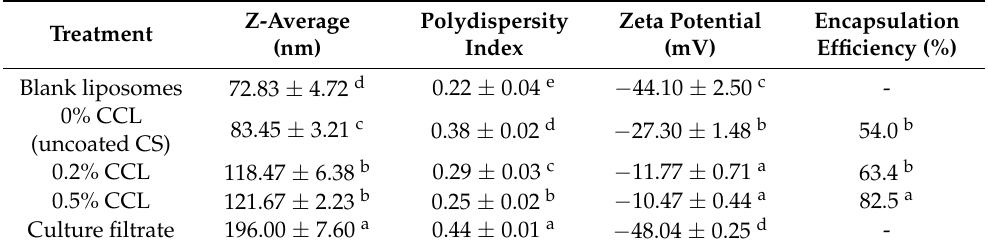
Table 1. Average diameter, polydispersity index, zeta potential, and encapsulation efficiency of chi- tosan (CS)—coated cyclic lipopeptide (CLP)—loaded liposome (CCL) on 0.5% lecithin phospholipid.